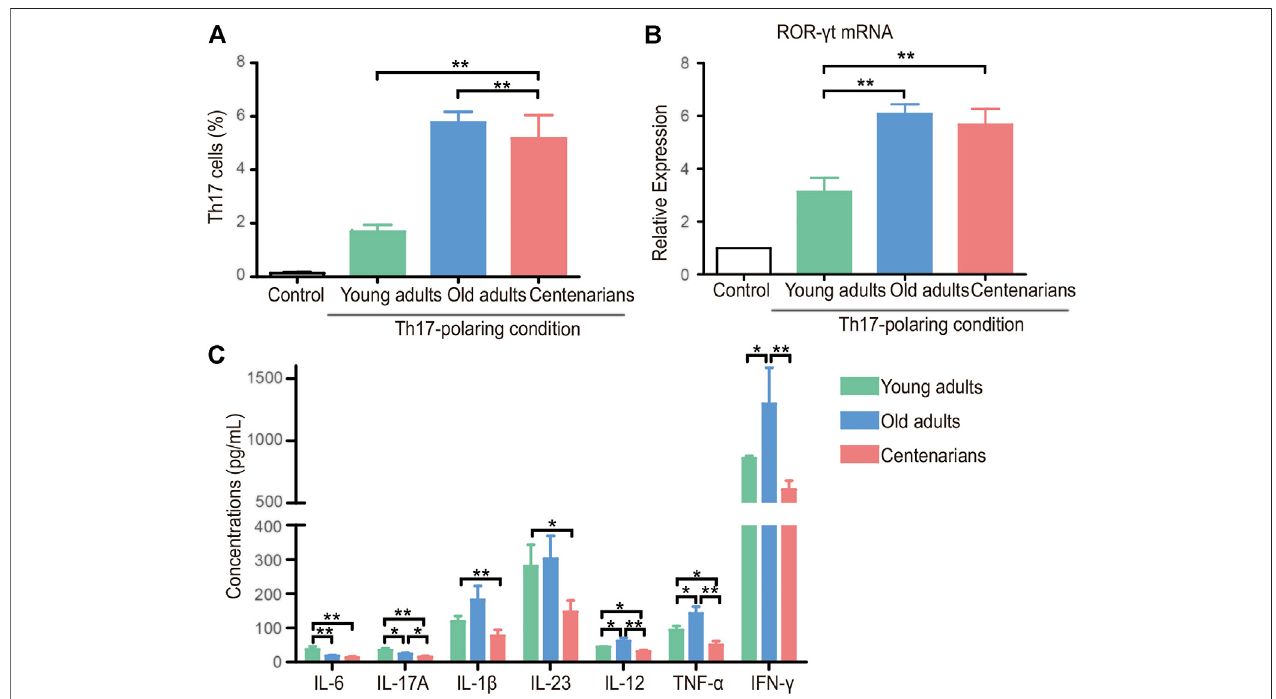
FIGURE 3 | Increased Th17 cells in centenarians secreted fewer proin fl ammatory cytokines in vitro . Naive CD4 + T cells from young adults, old adults and centenarians were stimulated with immobilized anti-CD3 and anti-CD28 monoclonal antibodies under Th17-polarizing conditions for 5 days in vitro . (A) Th17 cells were measuredbyFCM. (B) ROR- γ tmRNAlevelsweredeterminedbyqPCRinTh17-polarizingconditions. (C) ThesupernatantsinTh17-polarizingconditionswerecollected to detect the levels of IL-6, IL-17A, IL-1 β , IL-23, IL-12, TNF- α and IFN- γ by ELISA. Data were expressed as the mean ± SD. n = 8. Asterisks (*) indicate signi fi cant differences (* p < 0.05; ** p <